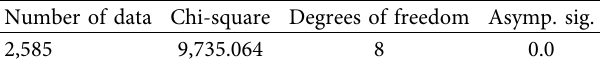
Table 3: Results of the Friedman test. Number of data Chi-square Degrees of freedom Asymp.